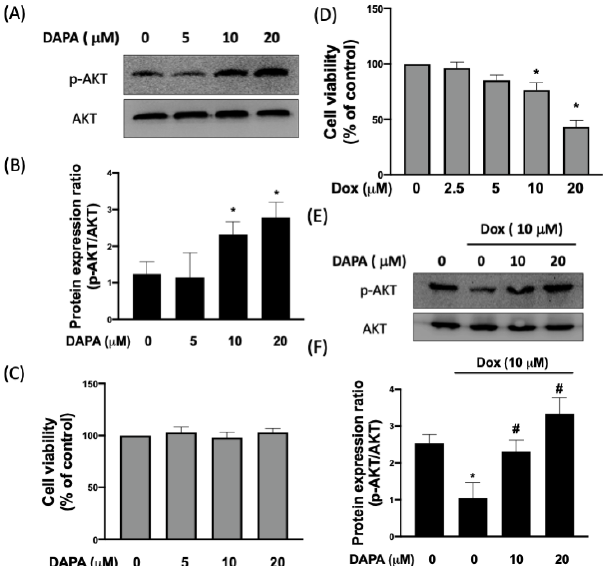
Figure 1. Treatment of DAPA restores the Dox-inhibited phosphorylation of AKT. Representative Western blot images ( A ) and densitometric analysis ( B ) of phosphorylated and total AKT levels in H9c2 cells treated with various concentrations of DAPA. Cell viability of H9c2 cells after DAPA treatment ( C ). The dosage-dependent manner of Dox exposure ( D ). Representative Western blot images ( E ) and densitometric analysis ( F ) of phosphorylated and total AKT levels in Dox-stimulated H9c2 cells following DAPA co-administration were shown. Results are shown as means ± SD of three independent experiments. Statistical analysis was performed using one-way ANOVA with a Bonferroni post hoc test. [* p < 0.05 compared to the control group; # p < 0.05 compared to the Dox-only